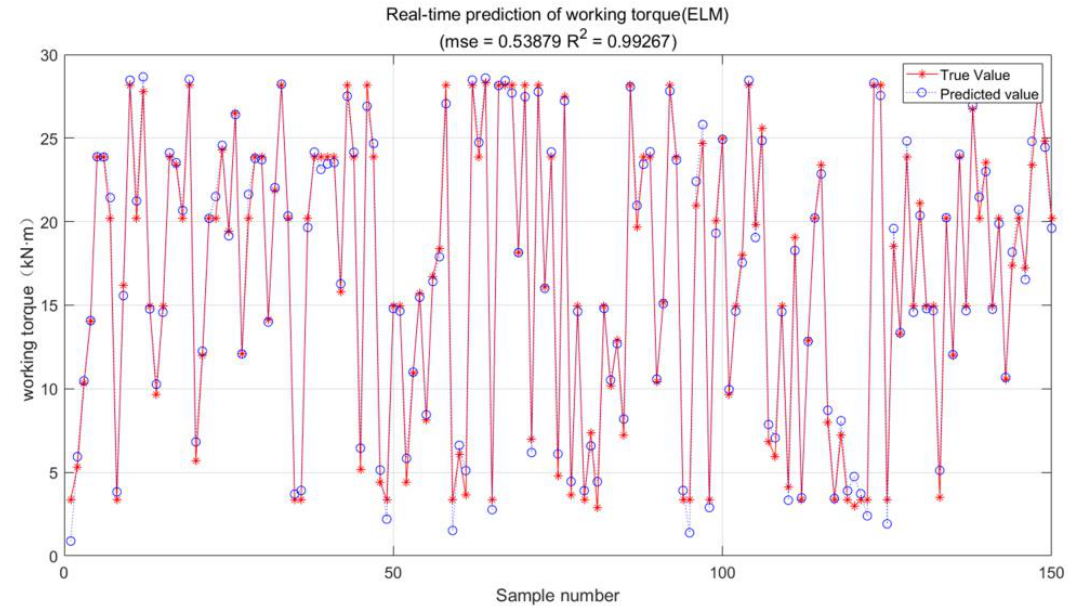
Figure 7. Real-time prediction of the working torque.